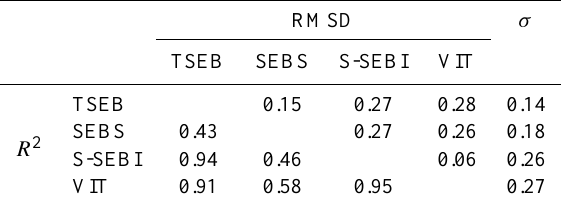
Table 6. Double-entry table of coefficient of determination R 2 (lower-left part) and RMSD (upper-right part) between the SEB models and their standard deviation σ on 6